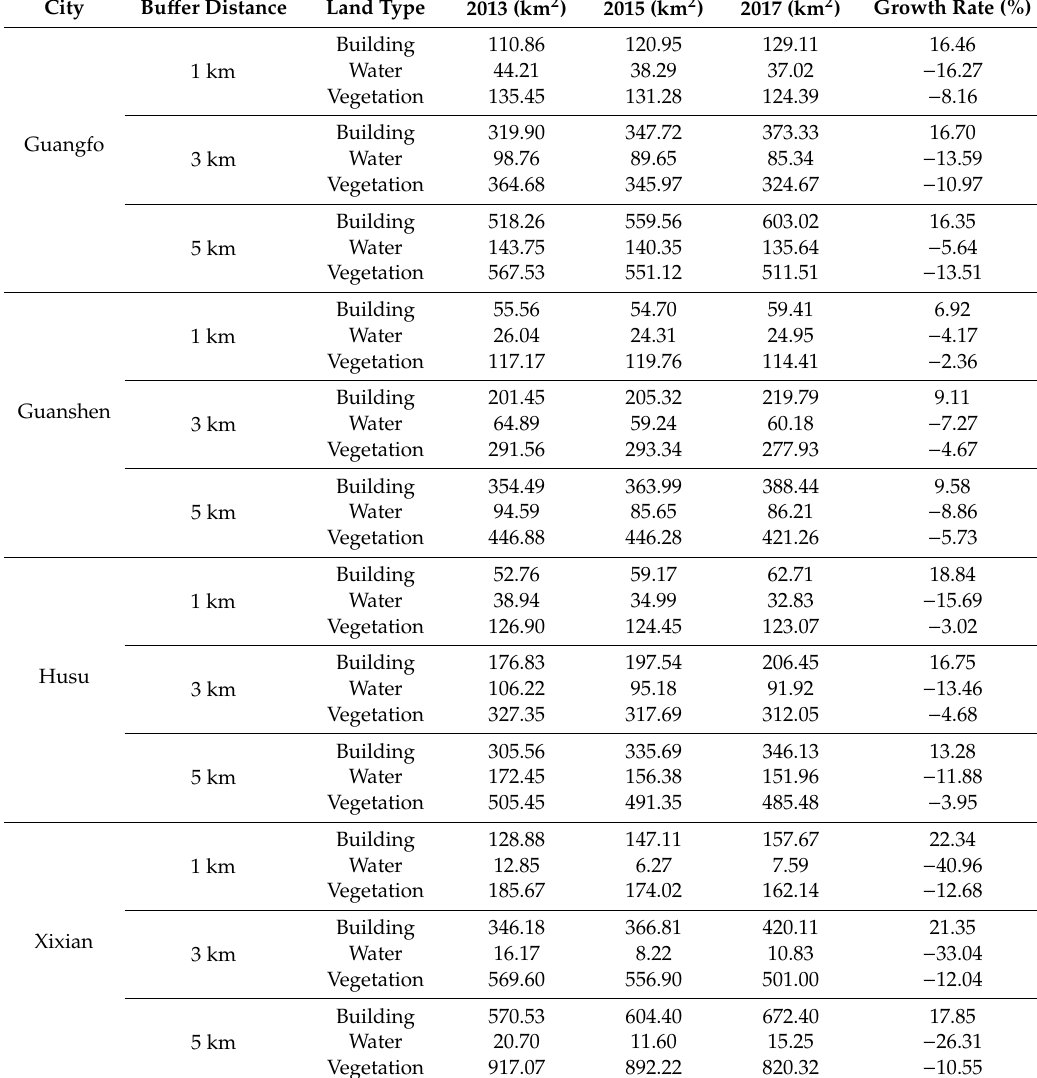
Table 2. Land-use classification results of boundary zones under multiple bu ff er distances. City Bu ff er